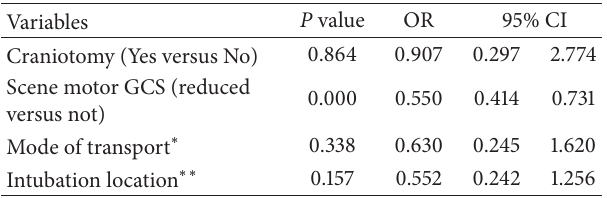
Table 2: Multivariate analysis for predictors of mortality among all intubated ISTBI